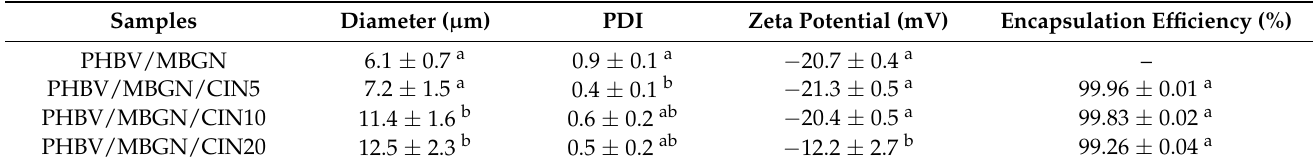
Table 1. Diameter, polydispersity index (PDI), zeta potential, and encapsulation efficiency of blank microspheres (PHBV/MBGN) and CIN-loaded microspheres ranging from 5 to 20% (v/v) (PHBV/MBGN/CIN5, PHBV/MBGN/CIN10, and